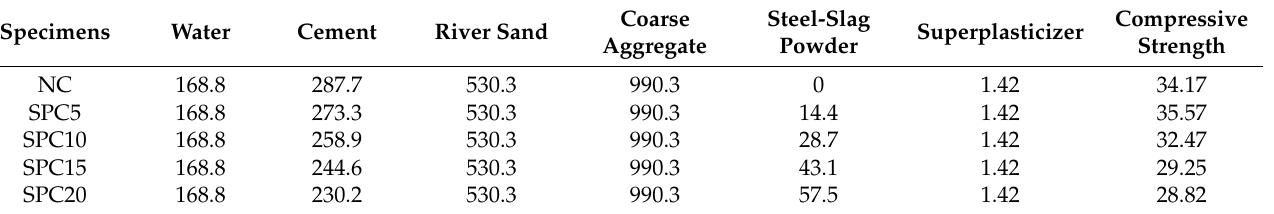
Figure 1. XRD pattern of steel-slag powder. Table 2. Mix proportions of SPC (kg/m 3 ) and the corresponding compressive strength (MPa).